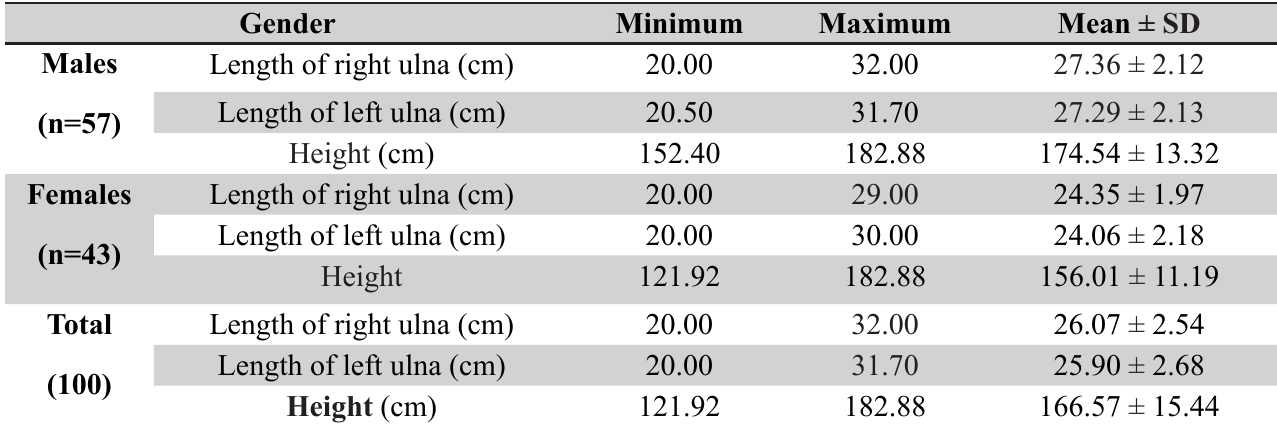
Table 1. Gender-wise variations in